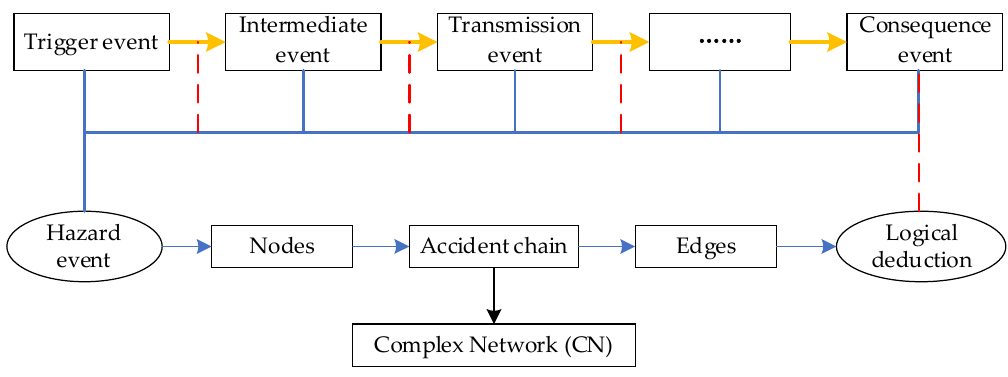
Figure 4. Schematic diagram of BT mapping into CN.